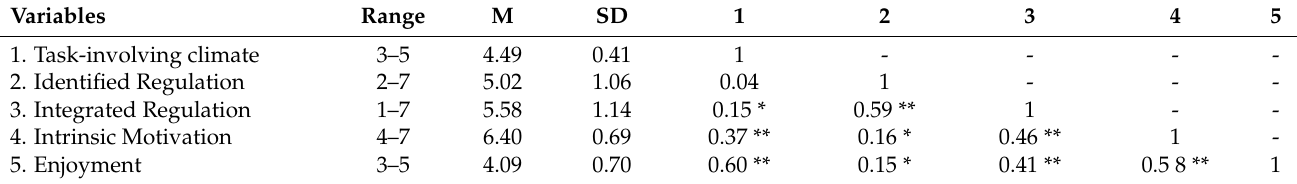
Table 1. Range, means, standard deviation, and bivariate correlation across the studied